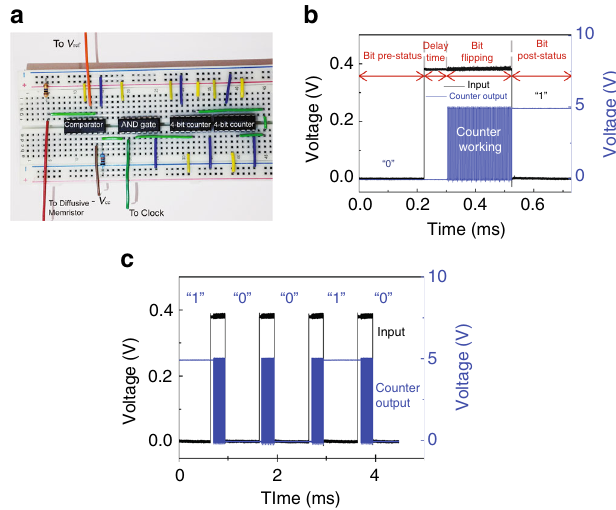
Fig. 3 Experimental demonstration of a diffusive memristor true random number generator. a Photo of our simple circuit built on a breadboard.